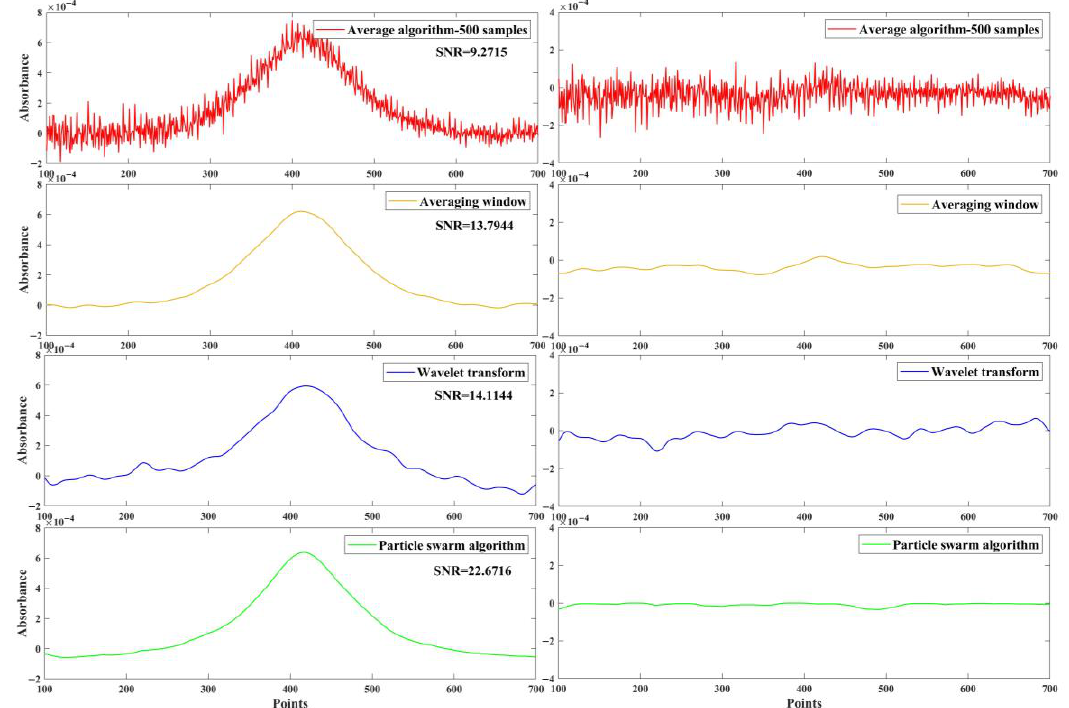
Figure 7. On the left are the results of original spectra processing with average algorithm, averaging window algorithm, wavelet transform, and our improved particle swarm algorithm. On the right is noise analysis.